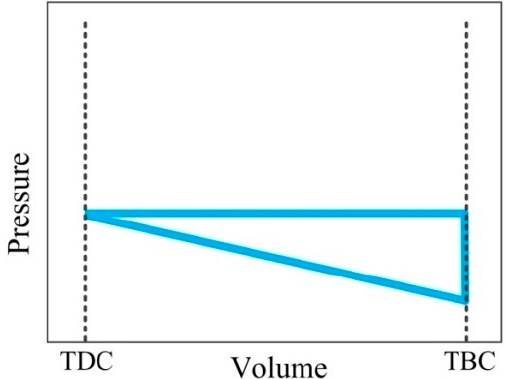
Figure 5. The schematic of in-cylinder pressure during the inactive cycle.